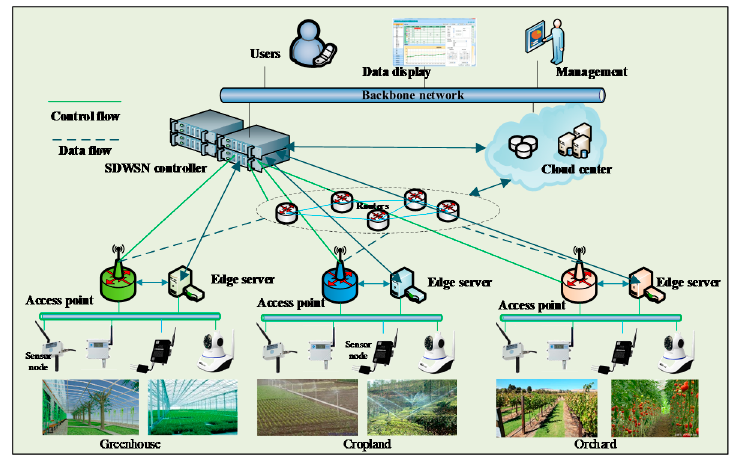
Figure 1. Agricultural data collection framework.